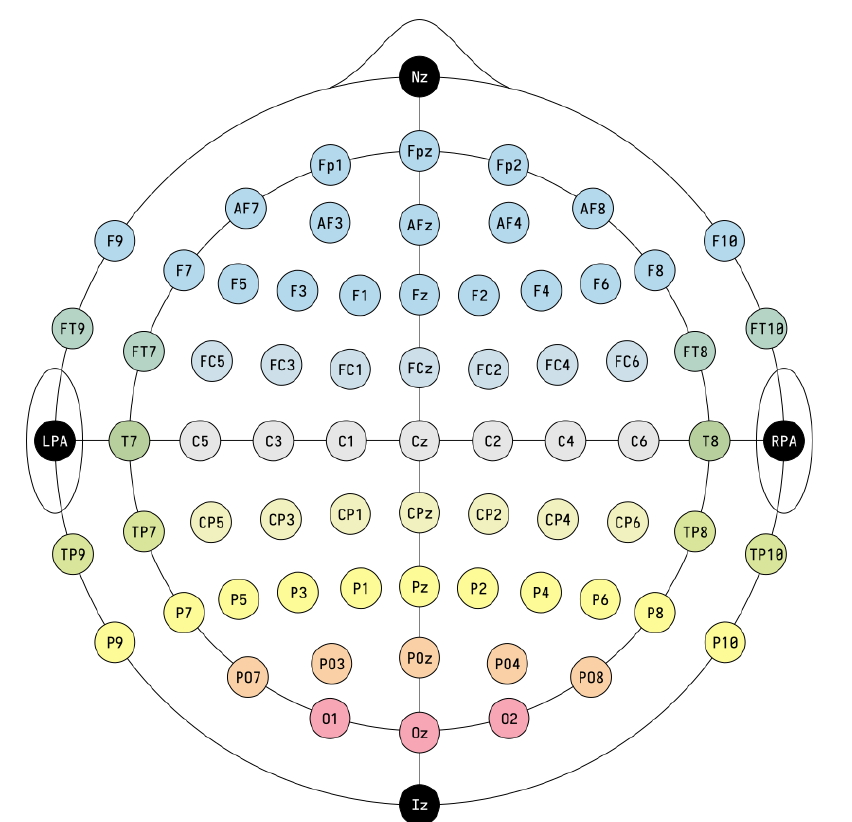
Figure 4. 10-10 International system (adapted from https://commons.wikimedia.org/w/index.php? curid=96859272 accessed on 31 January 2023). The letter correspondences are as follows: frontopolar (Fp), AF between Fp and F, frontal (F), FC between F and C, central (C), CP between C and P, parietal (P), PO between P and O, occipital (O), temporal (T), FT between F and T, TP between T and P. The system also presents the nasion (Nz), inion (Iz), left and right pre-auricular point (LPA and